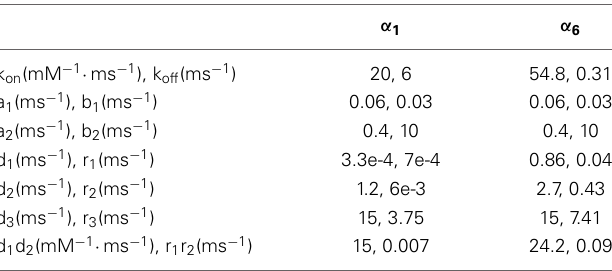
Table 3 | Kinetic rate constants used to simulate α 1 and α 6 GABA-A subunit-containing receptors in cerebellar granule